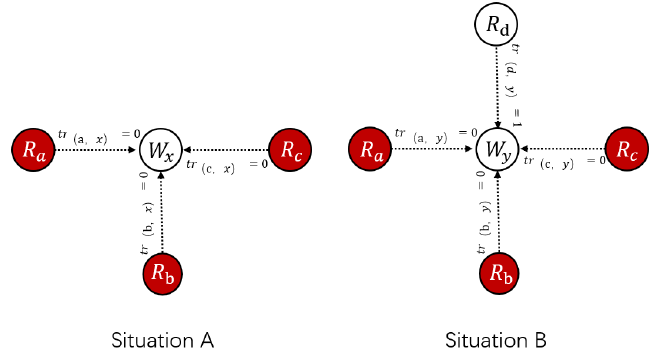
Figure 5. Attack situations where the CRH is